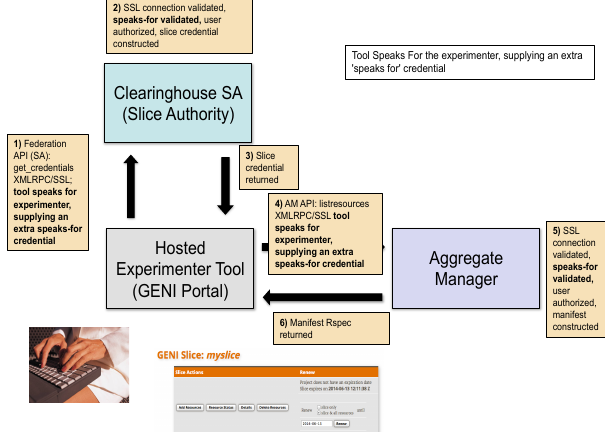
Figure 5. Trust Credentials at Work: Getting a slice credential in a hosted tool